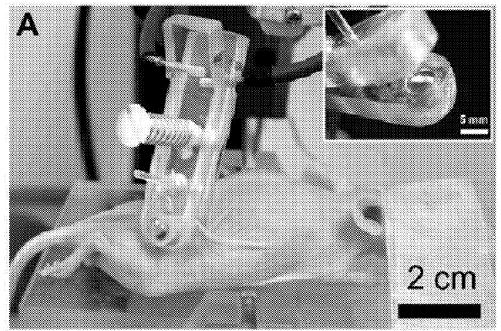
Figure 6. nsPEF device applied on SKH-1 hairless mouse to abolish melanoma cancer. Figure extracted from the patent titled “Nanosecond pulsed electric fields cause melanomas to self-destruct”. ID